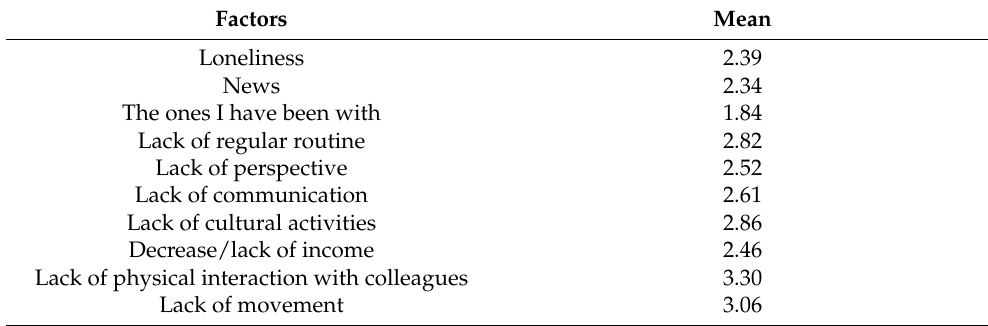
Table 4. Social and cultural factors that influenced the students’ emotional status during the lockdown. Factors